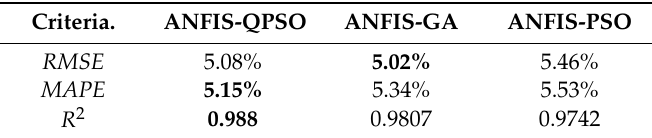
Table 12. Performance comparison of ANFIS-QPSO, ANFIS-GA and ANFIS-PSO for the cr + yogenic turning